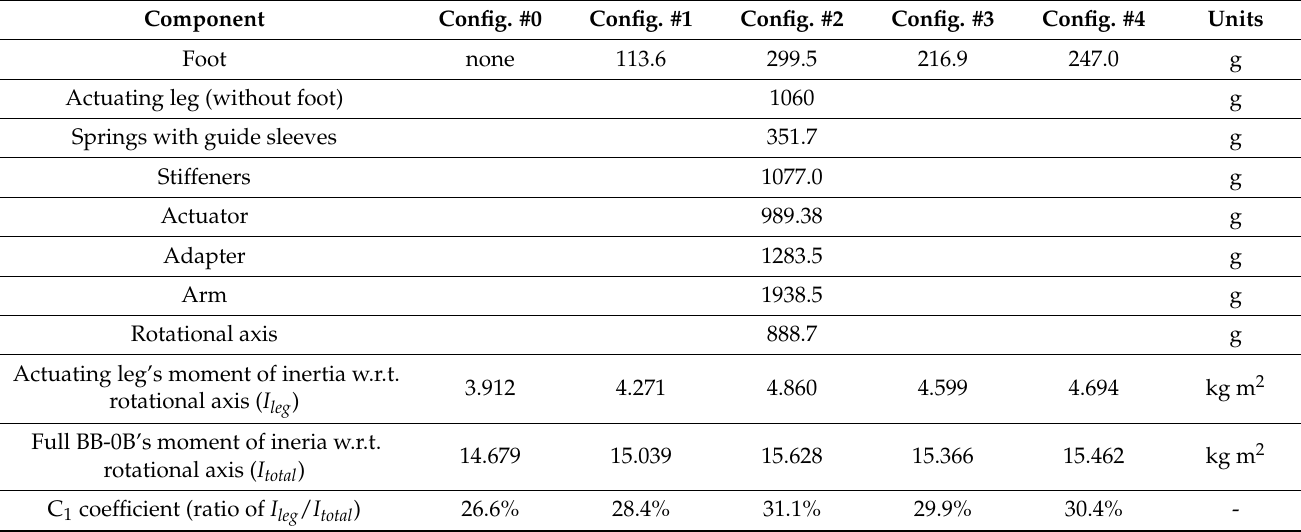
Figure 15. The overlayed sequence of BB-0B jump in MSC Adams with indicated major components and geometry. Table 3. Measured and calculated inertias of the